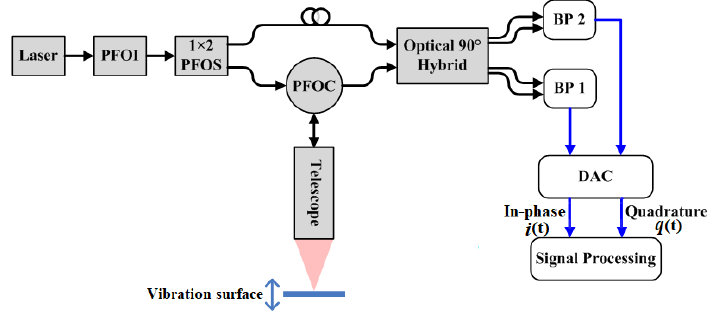
Figure 1. Schematic layout of the homodyne LDV.